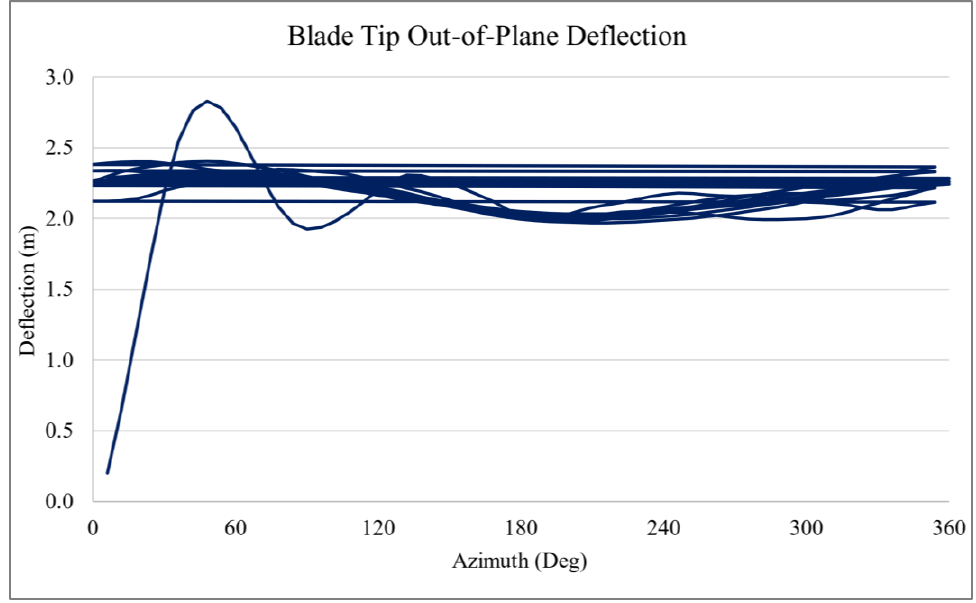
Figure 8. Blade Tip Out-of-Plane Deflection with Azimuth Angle - 1% Turbulence Intensity